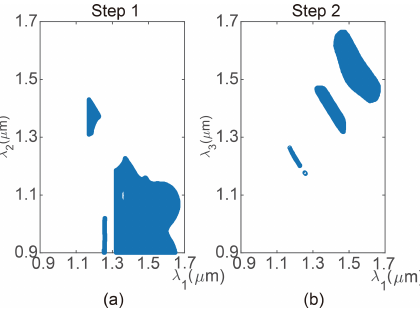
Figure 6. (a) Appropriate values of λ 1 and λ 2 for minimum overlap between the classes for step 1. (b) Appropriate values of λ 1 and λ 3 for minimum overlap between the classes for step 2. Table 3. Appropriate wavelength